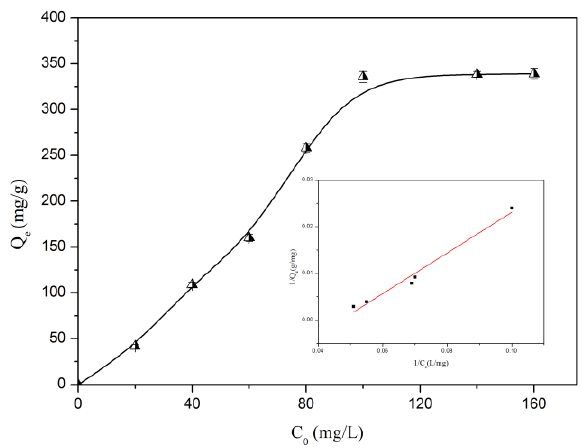
Figure 9. Isotherms of Pb(II) adsorption on CLNPs. The inset shows the fitting results of the Langmuir model for Pb(II) adsorption (CLNP dosage = 15 mg/50 mL, temperature = 30 °C, pH = 6.03).